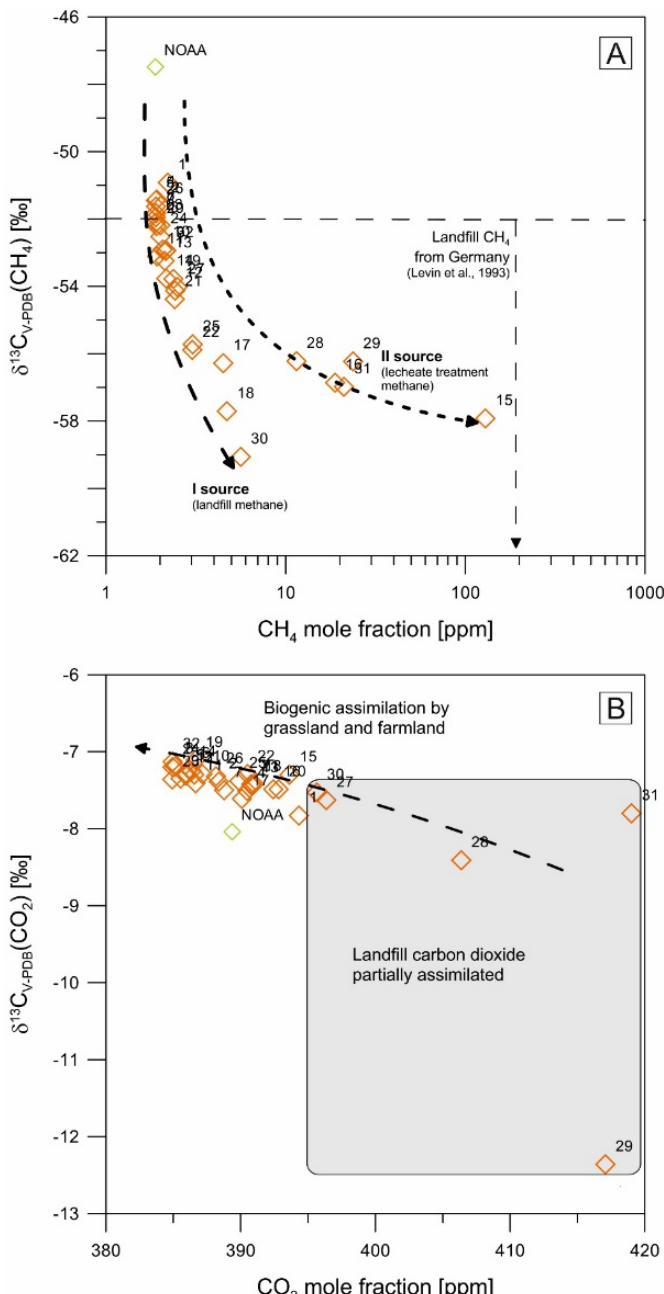
Figure 5. Relations between mole fraction and carbon isotopes composition of methane ( A ) and carbon dioxide ( B ) from ambient air gathered in the vicinity of municipal waste landfill sampled during the 22 August 2017 campaign. Dashed lines show the linear regression fit for the data sampled. The green dots represent average background values according Mace Head Research Station, Ireland, NOAA. Black solid/dashed lines represent expected source contribution range.